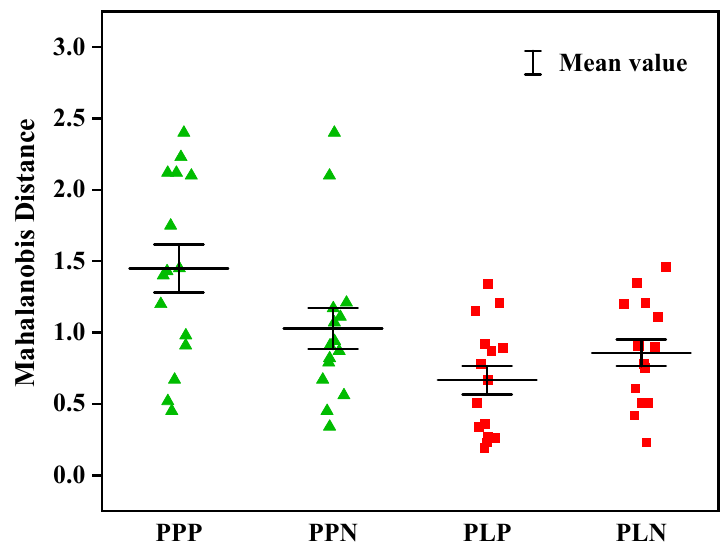
Figure 8. External verification results of the LDA identification models.